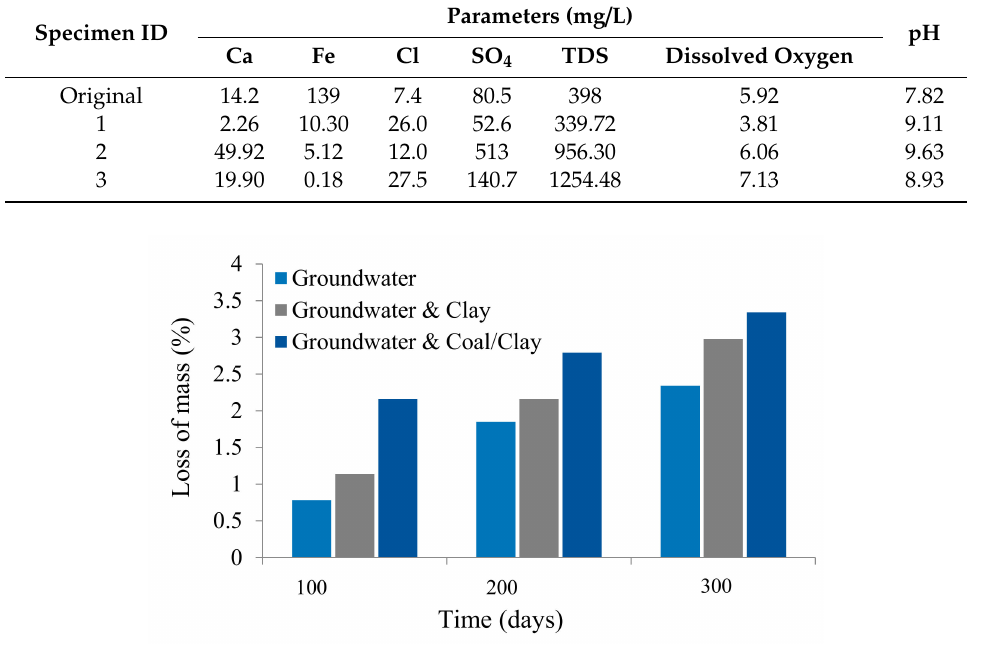
Figure 10. Weight loss of the specimens due to